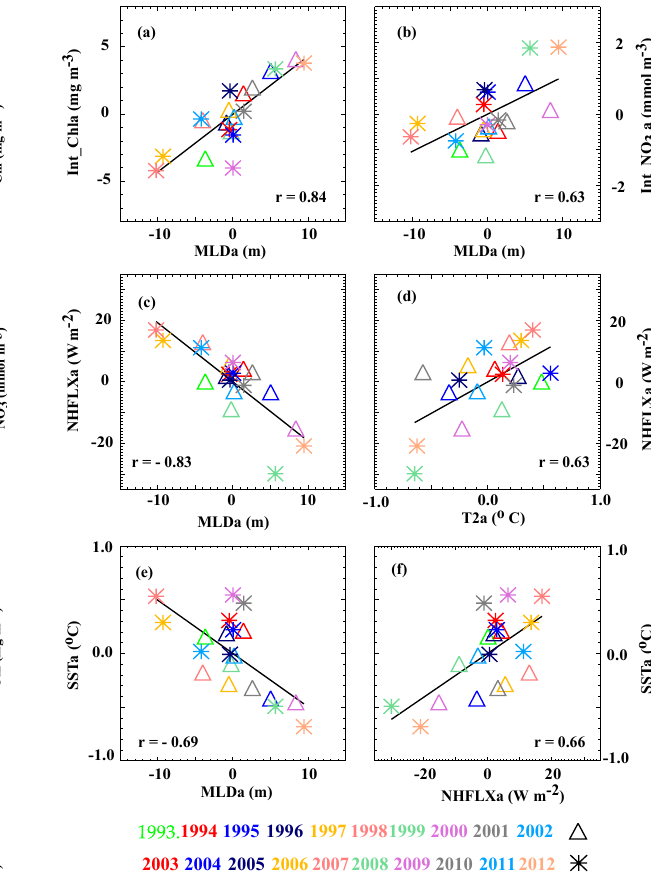
Figure 12. Scatter plot of modelled interannual NAS-box-averaged winter (February–March) anomalies of (a) 0–200m total chloro- phyll content against MLD. (b) Average MLD nitrate vs. MLD. (c) Surface net heat flux vs. MLD. (d) Surface net heat flux vs. 2m air temperature. (e) SST vs. MLD. (f) SST vs. surface net heat flux. Plain lines indicate regression coefficients that are significantly dif- ferent from zero at the 90% confidence